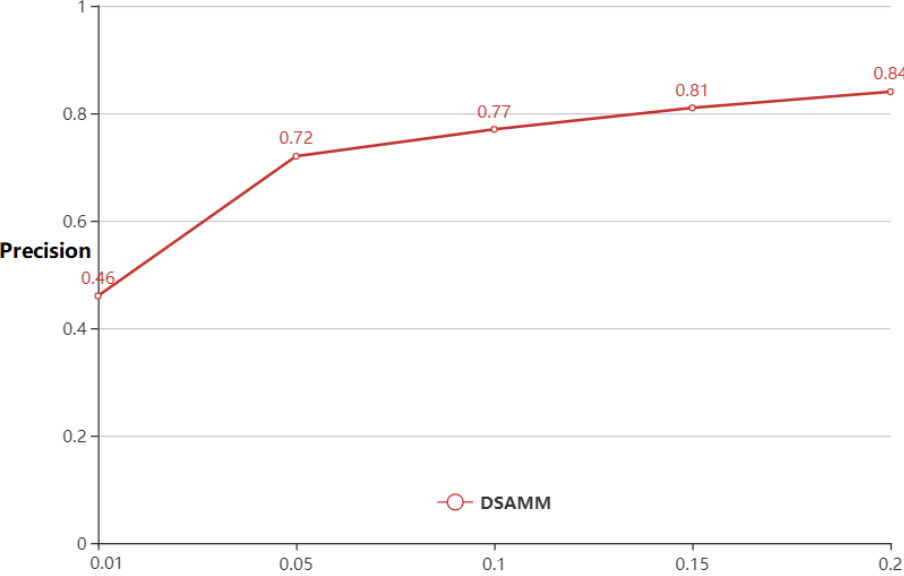
Figure 6. Comparison of the precision of the validation set of the DSAMM instances with different scaled training sets with labels.